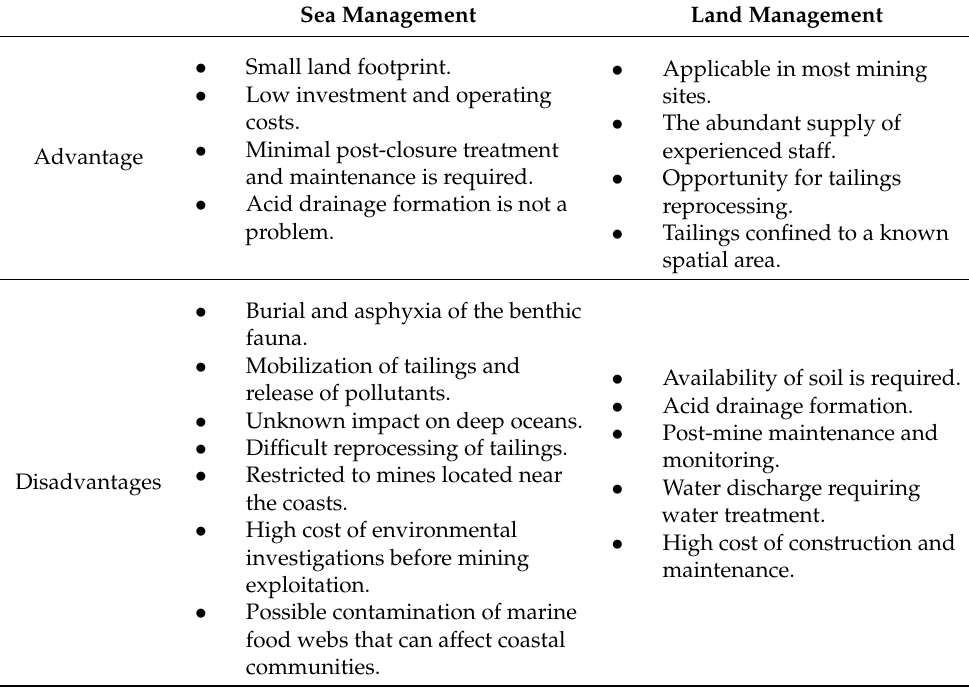
Table 1. Advantages and disadvantages of land and sea tailings management